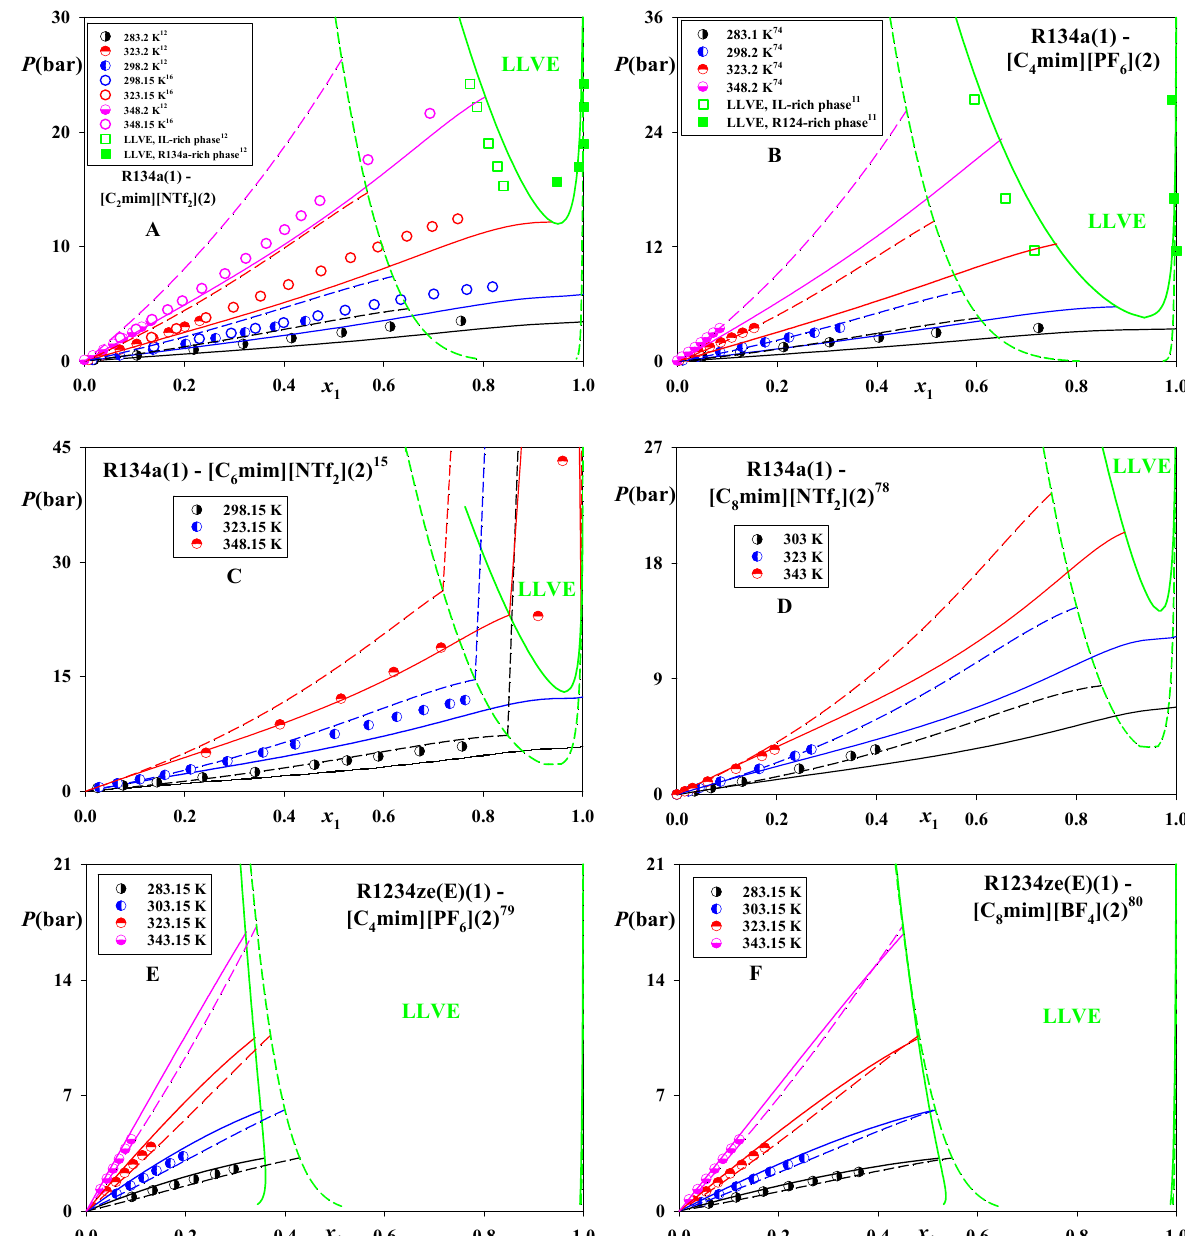
Figure 4. Phase equilibria in the systems of R134a and R1234ze( E ) dissolved in [C 2 mim][NTf 2 ], [C 6 mim][NTf 2 ], [C 8 mim][NTf 2 ], [C 8 mim][BF 4 ], and [C 4 mim][PF 6 ]. Points—experimental data [11,12,15,16,74,78–80]. Solid lines— predictions of CP-PC-SAFT, dashed lines — predictions of SAFT-VR-Mie. k 12 = 0 for both models.